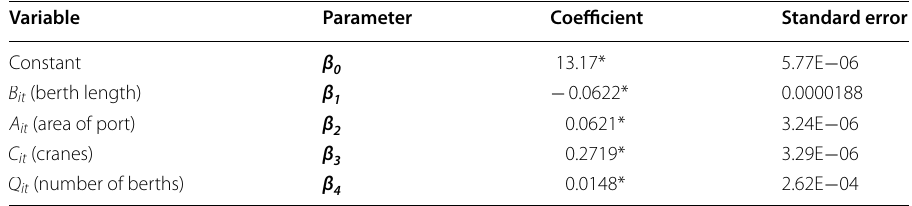
* Significant at 1%